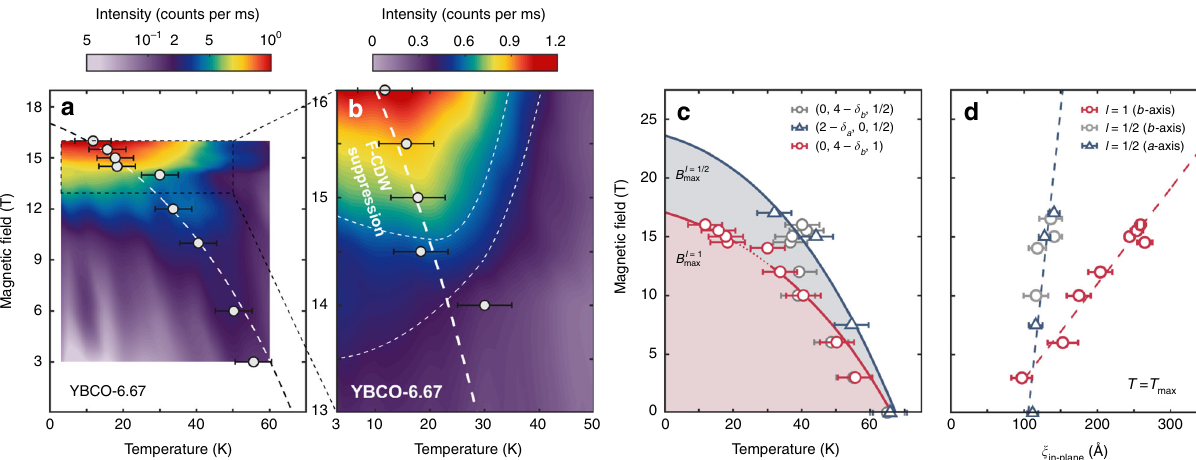
Fig. 6 Competing temperature and magnetic fi eld scales. a Intensity map of (0, 4 – δ b , 1) (logarithmic colour scale) as a function of temperature and magnetic fi eld. The open circles indicate the temperature scale T ‘ ¼ 1 below which suppression of the F-CDW order is observed (Figs. 4a – c). The curved max dashed line is a guide to the eye. b Intensity map (linear colour scale) focusing on the high-magnetic- fi eld region. The thin dashed lines indicate contour lines. c T scales inferred from the ℓ = 1 ∕ 2 (red) and ℓ = 1 (blue) charge-density-wave, respectively. Solid lines are guides to the eye. For the ℓ = 1 ∕ max 2 T temperature scale, triangular and circular data points stem from data recorded along the a - (ref. 9 ) and b -axis (this work) respectively. As the T max max temperature scales indicate the onset of competition with superconductivity, these lines are labelled B ‘ ¼ 1 and B ‘ ¼ 1 = 2 c in the T → 0 limit. Error bars indicate 2 c 2 the uncertainty related to the determination of the T temperature scales. d Correlation lengths ξ ‘ ¼ 1 = 2 b and ξ ‘ ¼ 1 b at the respective T temperature values. max max Source data are provided as a Source Data fi